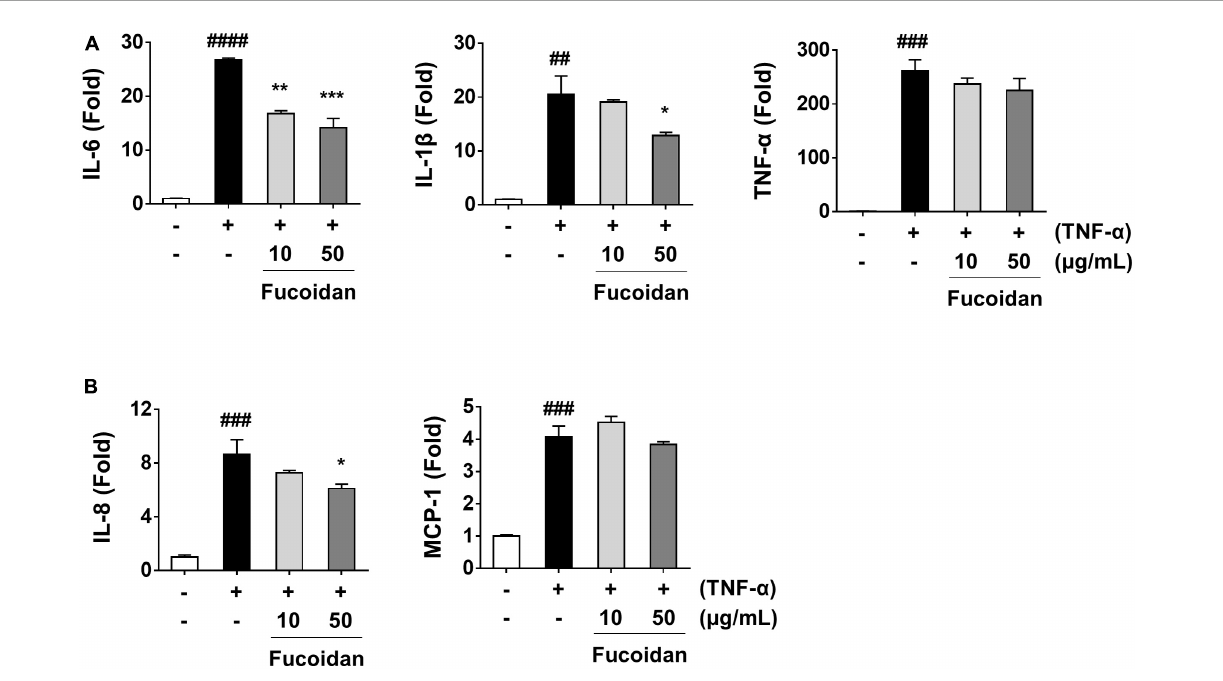
FIGURE6 Effect of fucoidan on mRNA expression of pro-inflammatory mediators in TNF- α -stimulated ARPE-19 cells. ARPE-19 cells were pre-treated with fucoidan for 1 h and then stimulated with 50 ng/mL TNF- α for 1 h. The mRNA expression was analyzed by real-time RT-PCR. mRNA expression levels of (A) the cytokines IL-6, IL-1 β , and TNF- α and (B) the chemokines IL-8 and MCP-1. The values represent the mean ± SD of three independent experiments. ## p < 0.01, ### p < 0.001 and #### p < 0.0001 compared with the control. * p < 0.05, ** p < 0.01 and *** p < 0.001 compared with the TNF- α -treated control,